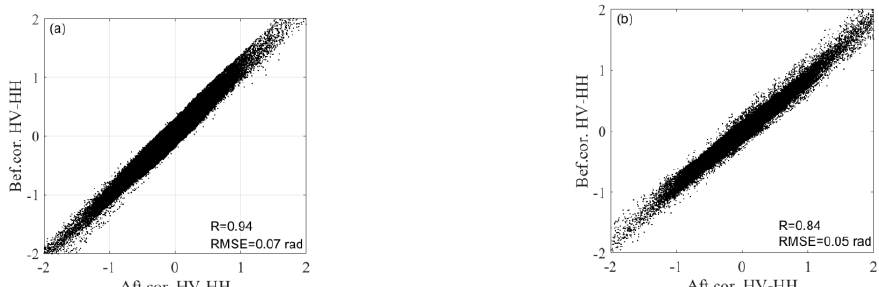
Figure 18. Joint distribution of the differences of the HV and HH D-Infs before and after atmospheric effects correction ( a ) San Francisco test site; ( b ) Moron test site.